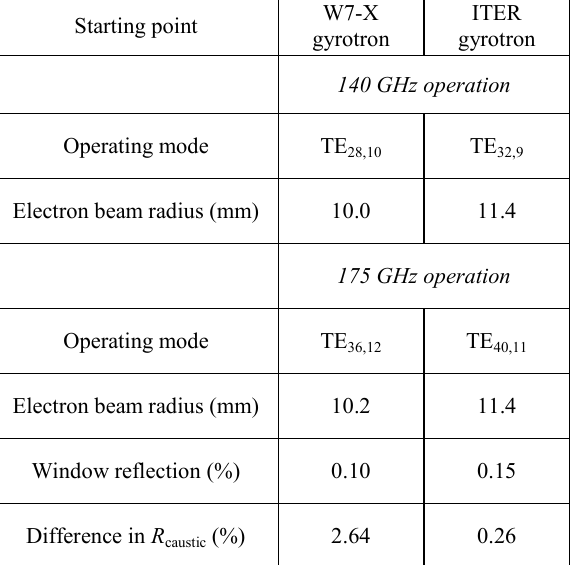
Table 1. Possible modes for the upgraded W7-X gyrotron. Starting point